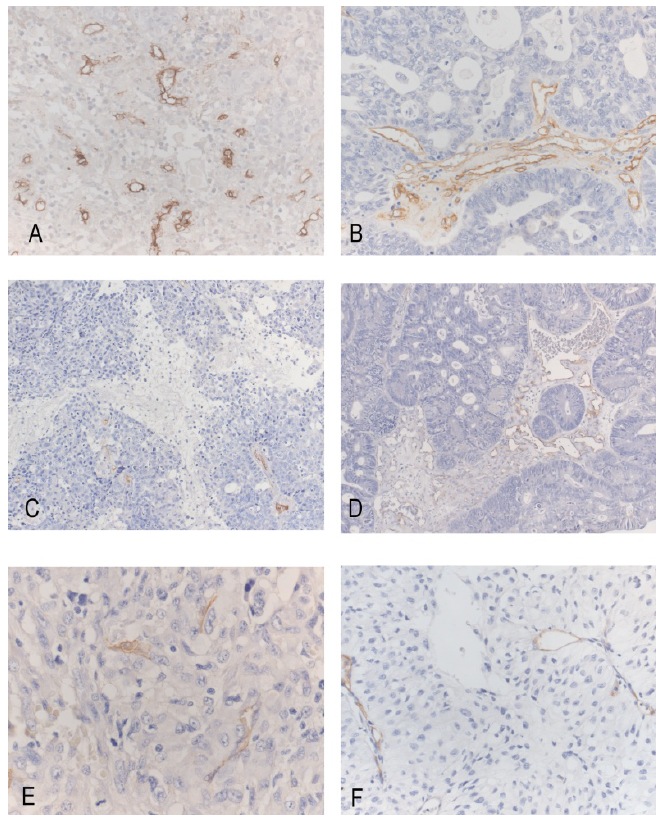
Figure 1. Endoglin-positive vessels in BM from ( A ) large cell carcinoma (endoglin stain; original magnification; ×200); ( B ) adenocarcinoma of the lung (endoglin stain; original magnification; ×200); ( C ) breast ductal adenocarcinoma (endoglin stain; original magnification; ×200); ( D ) CRC (endoglin stain; original magnification; ×100); ( E ) pulmonary squamous cell carcinoma (endoglin stain; original magnification; ×200);